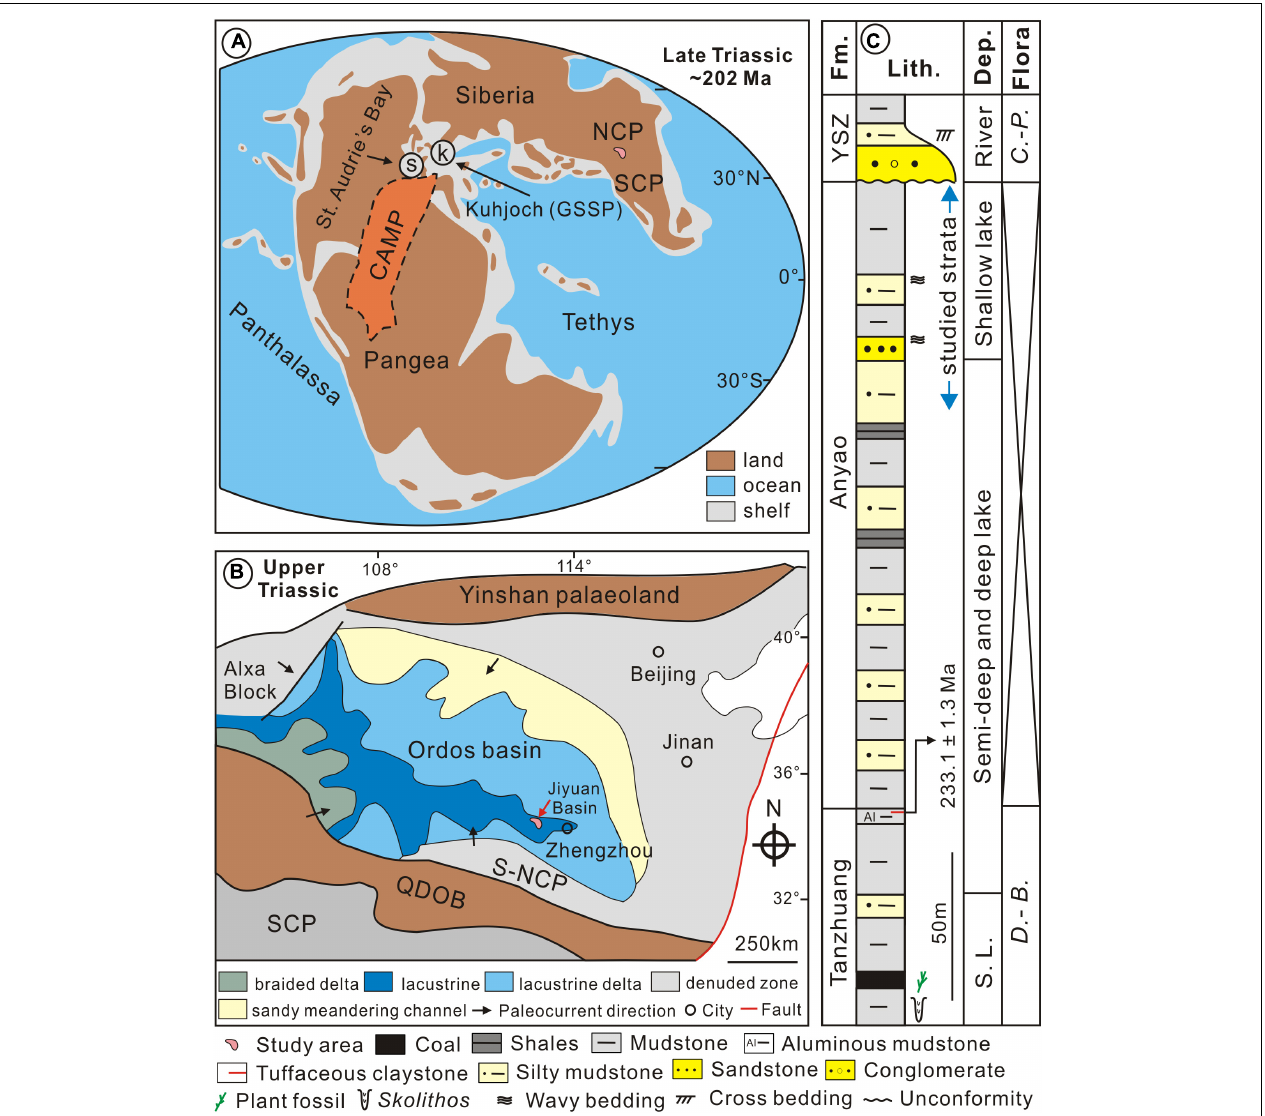
FIGURE 1 | Location and geological context for the study area. (A) Paleogeographic reconstruction for the Late Triassic ( ∼ 202 Ma) showing the location of the NCP and approximate extent of CAMP (revised after Greene et al., 2012); (B) simplified tectonic map of the southern NCP during the Late Triassic showing the location of the study area (modified from Liu et al., 2013); (C) stratigraphic framework of the Tanzhuang Formation to the Lower Yangshuzhuang (YSZ) Formation from the Jiyuan Basin (modified from Yang et al., 2012). Depositional environments come from Li et al. (2014). Note that U-Pb dating (233.1 ± 1.3 Ma) come from Lu et al. (2021a). CAMP, Central Atlantic Magmatic Province; NCP, North China Plate; SCP, South China Plate; QDOB, Qinling-Dabie Orogenic Belt; S-NCP, southern North China Plate; Fm., Formation; Lith., Lithology; Dep., Depositional environment; C .- P ., Coniopteris - Phoenicopsis